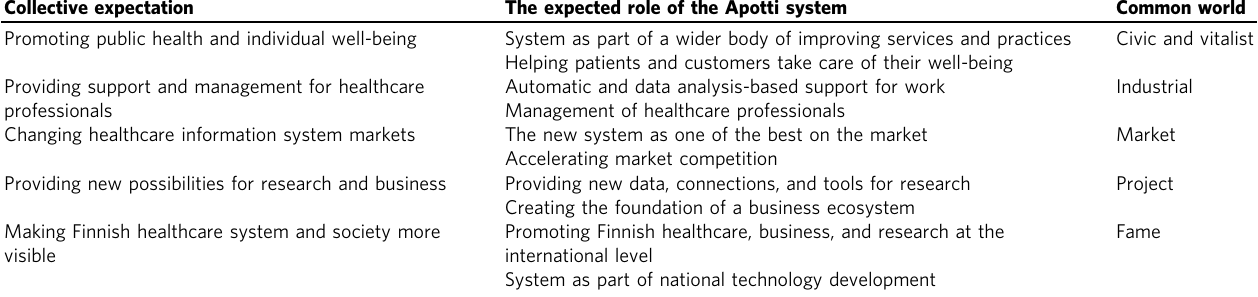
Table 2 The common good in the collective expectations of